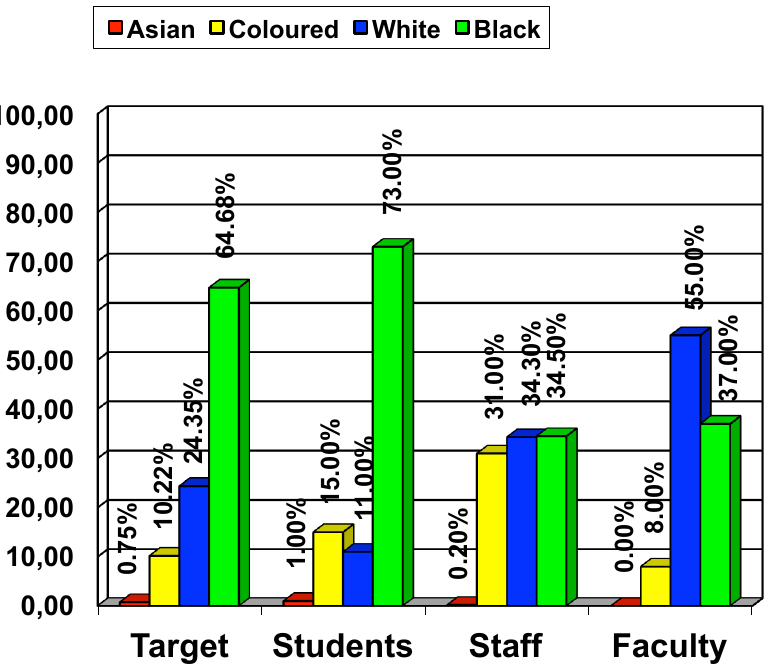
Figure 3: Overall racial transformation profile of Military